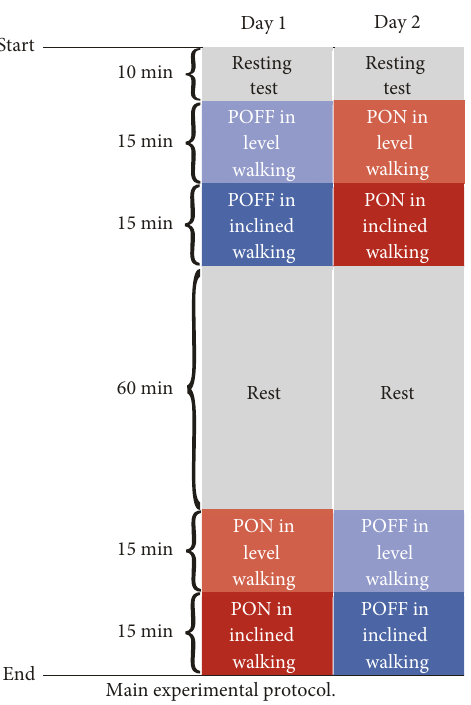
Figure 5: Main experimental